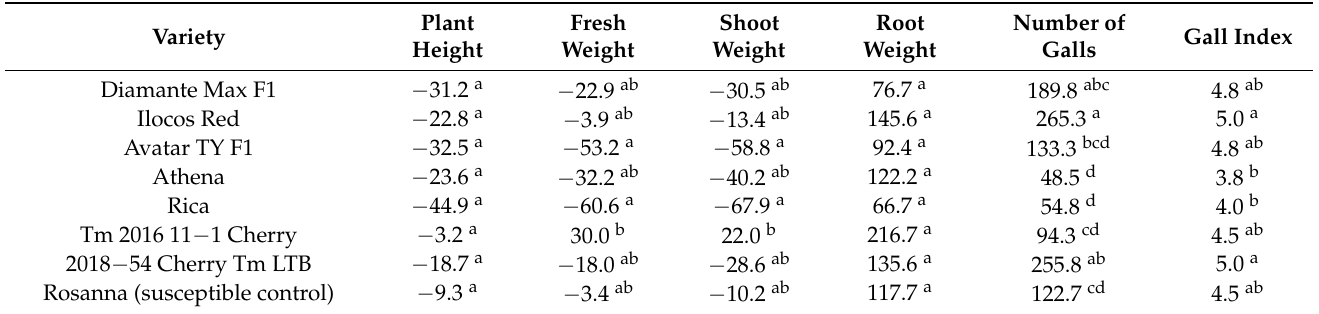
Table 1. Effects on plant growth, the number of root galls and the gall index of tomato varieties infected with Meloidogyne incognita .